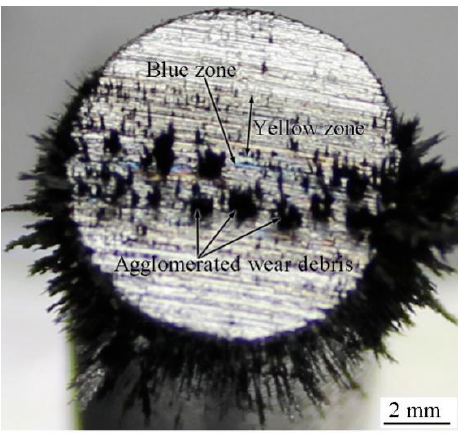
Figure 6 Macro-photograph of the pin when the RD was not used. H = 26.1 × 10 3 A/m.